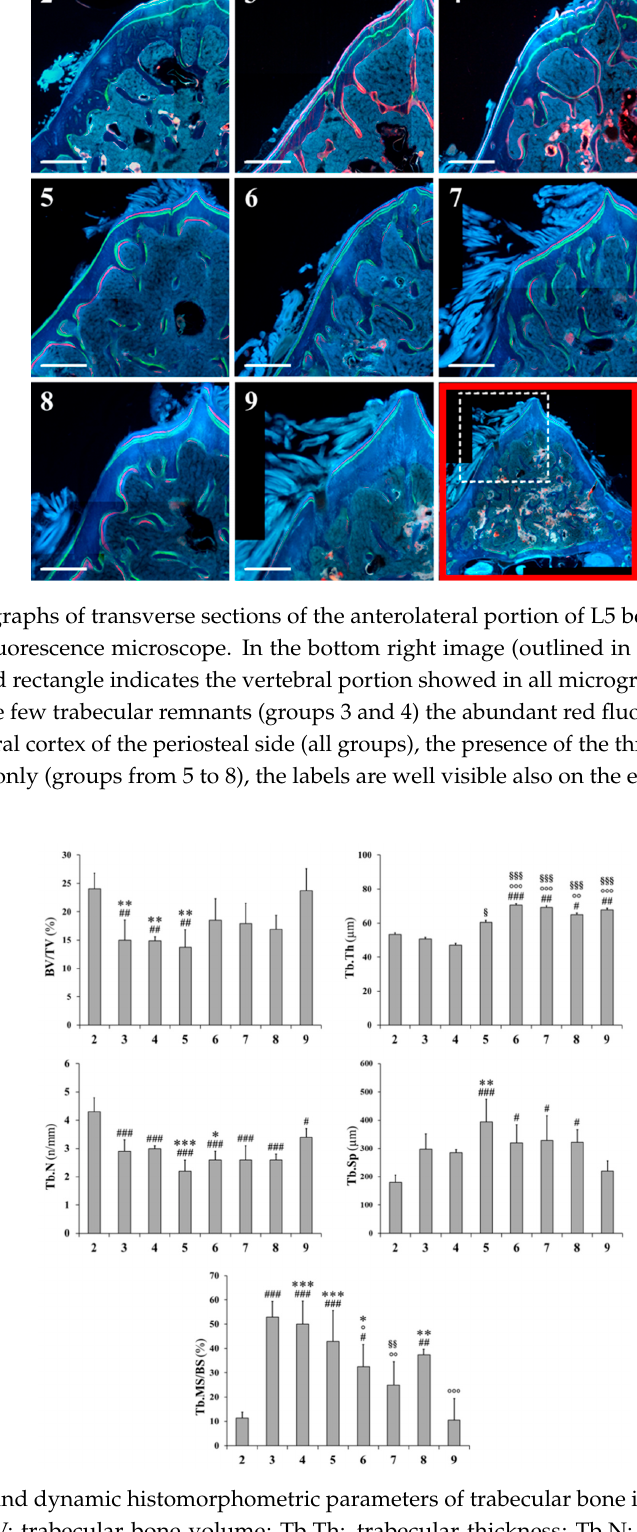
Figure 5. Static and dynamic histomorphometric parameters of cortical bone in L5 vertebral body sections. Ct.Th: cortical bone thickness; Ct.MAR: cortical mineral apposition rate. Values are